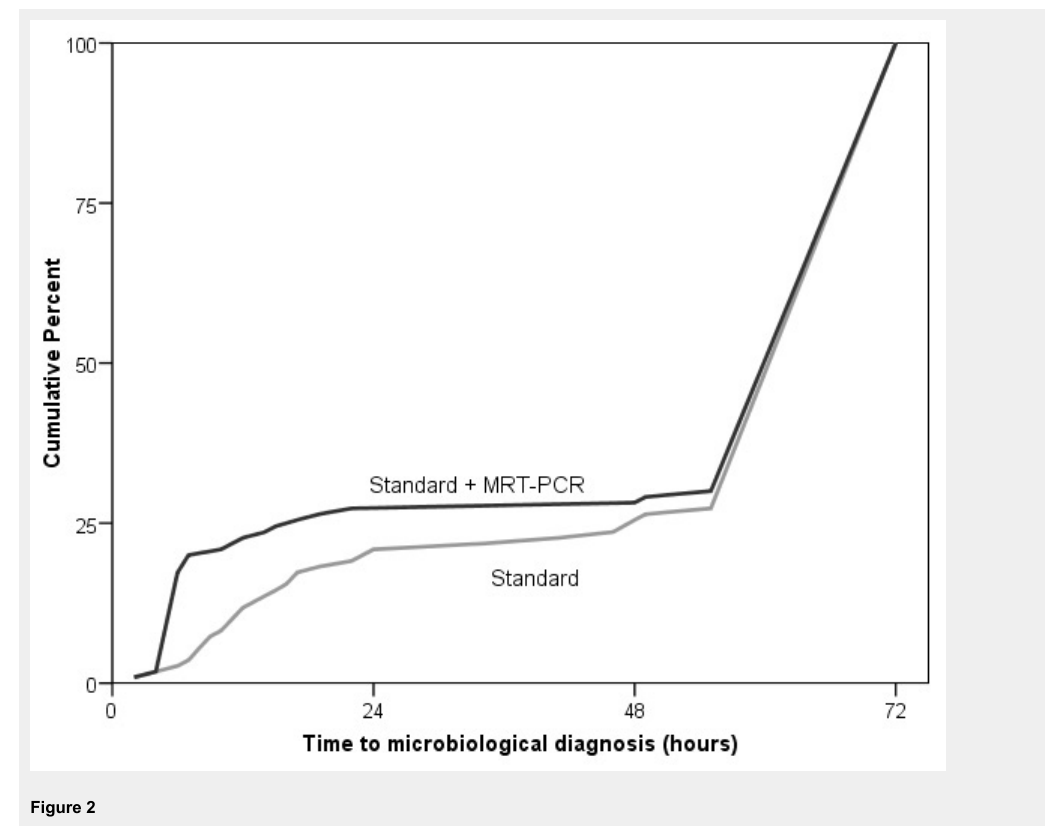
Figure 2 Time to microbiological diagnosis. Cumulative frequency distribution curve for the time to microbiological diagnosis during the first 72 hours with conventional microbiological methods (“standard”) compared to the multiplex real-time polymerase chain reaction (MRT-PCR). The microbiological diagnosis of the causative organism was achieved significant earlier with the combination of MRT-PCR and conventional microbiological methods compared to the conventional microbiological methods alone (Wilcoxon p ≤0.001). The median time gained until microbiological diagnosis was 3.9 hours (range